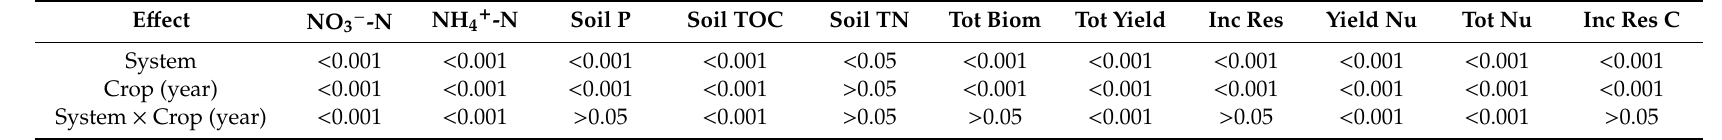
Table 4. Results of the mixed model analysis on agronomic parameters (P levels). See material and methods for explanations.